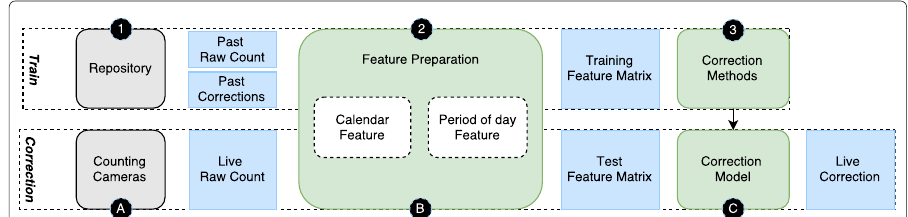
Fig. 2 Overview of the PreCount